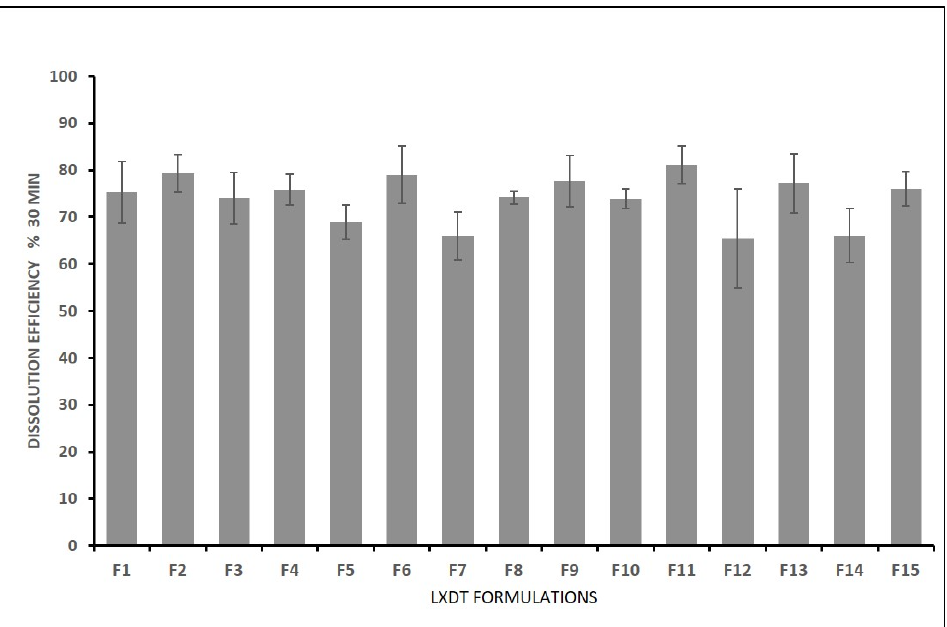
Figure 7. In vitro dissolution efficiency of LXDT after 30 min.